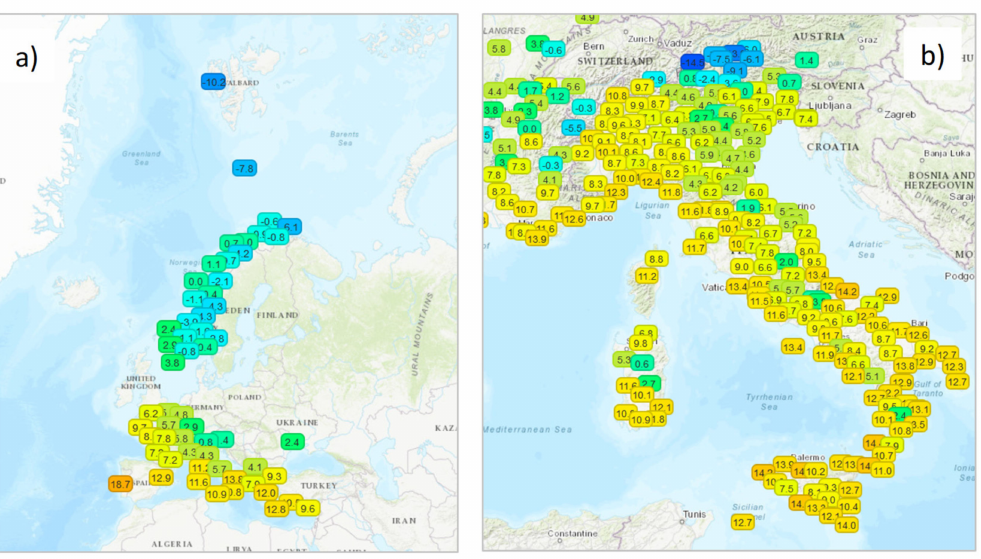
Figure 4. Real-time values over Europe ( a ) and a zoom over Italy ( b ) as they appear on the MNW web